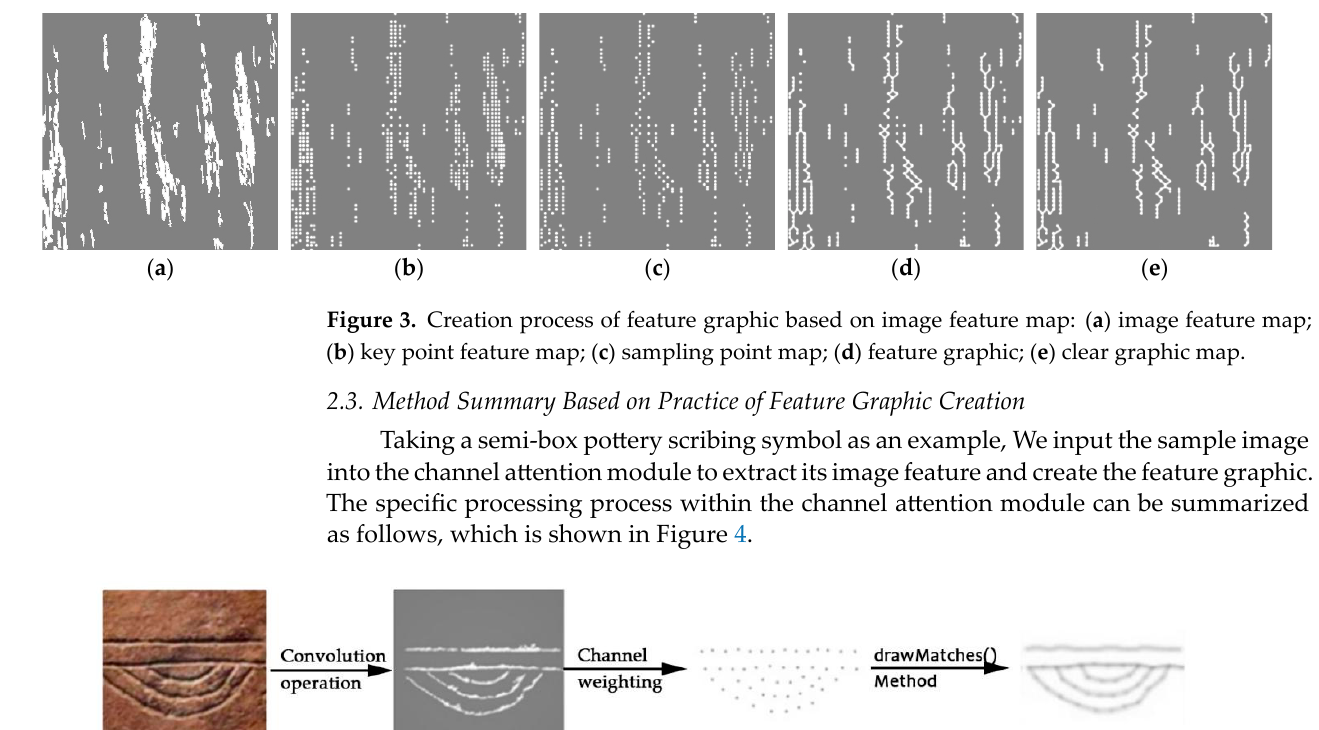
Figure 3. Creation process of feature graphic based on image feature map: ( a ) image feature map; ( b ) key point feature map; ( c ) sampling point map; ( d ) feature graphic; ( e ) clear graphic map.